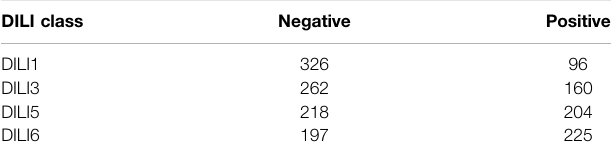
TABLE 3 | Training Data Imbalance. The data used for the clinical DILI classes of DILI1 and DILI3 were imbalanced which negatively in fl uenced the models built to predict these